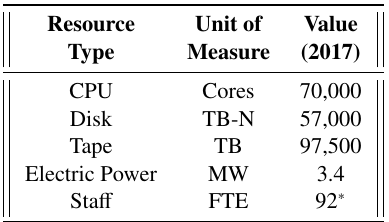
Table 1: INFN computing infrastructure (end of